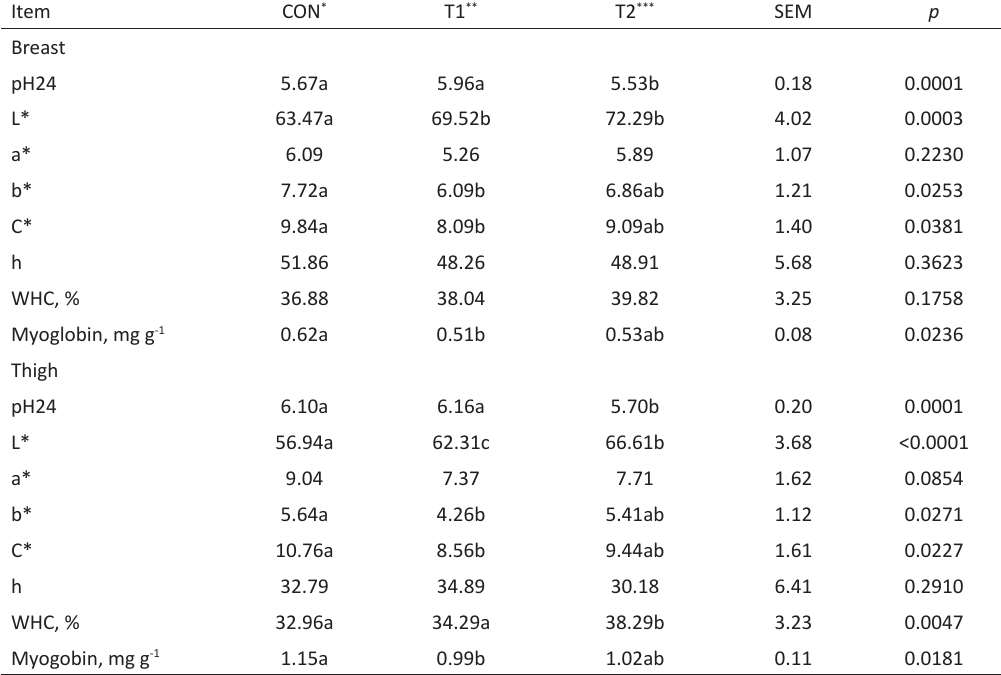
Table 4. Quality traits of the breast and thigh